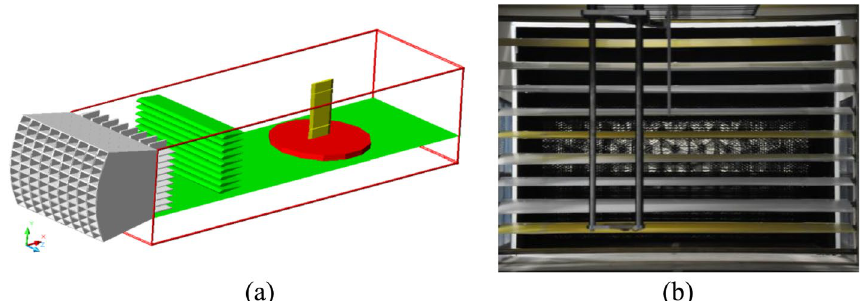
Fig. 9 Sketch of the combined vibrating-grid and active-fan turbulence simulation load device. a Tri-dimensional effects sketch. b Sketch of the installed equipment inside the wind